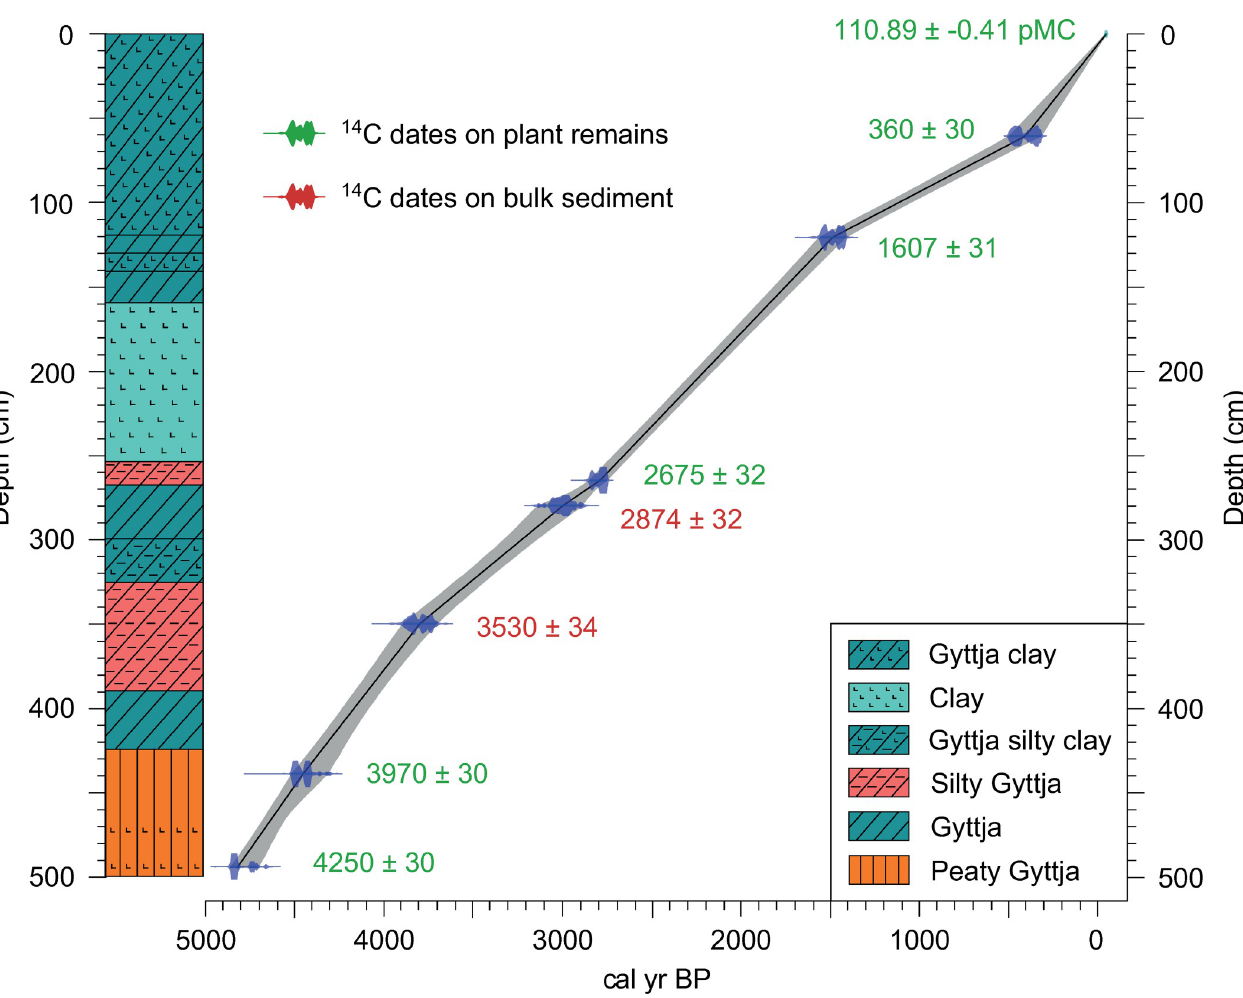
Fig 2. Sedimentological and chronological sequence of the study core from ancient Lake Lerna (Peloponnese, Greece). (left) Sediment succession and (right) age-depth model, built with Clam 4.1.1 R-package (linear interpolation; [63]) and based on 8 radiocarbon ages (calibrated with IntCal20; [62]). Results of radiocarbon dating have been previously published by